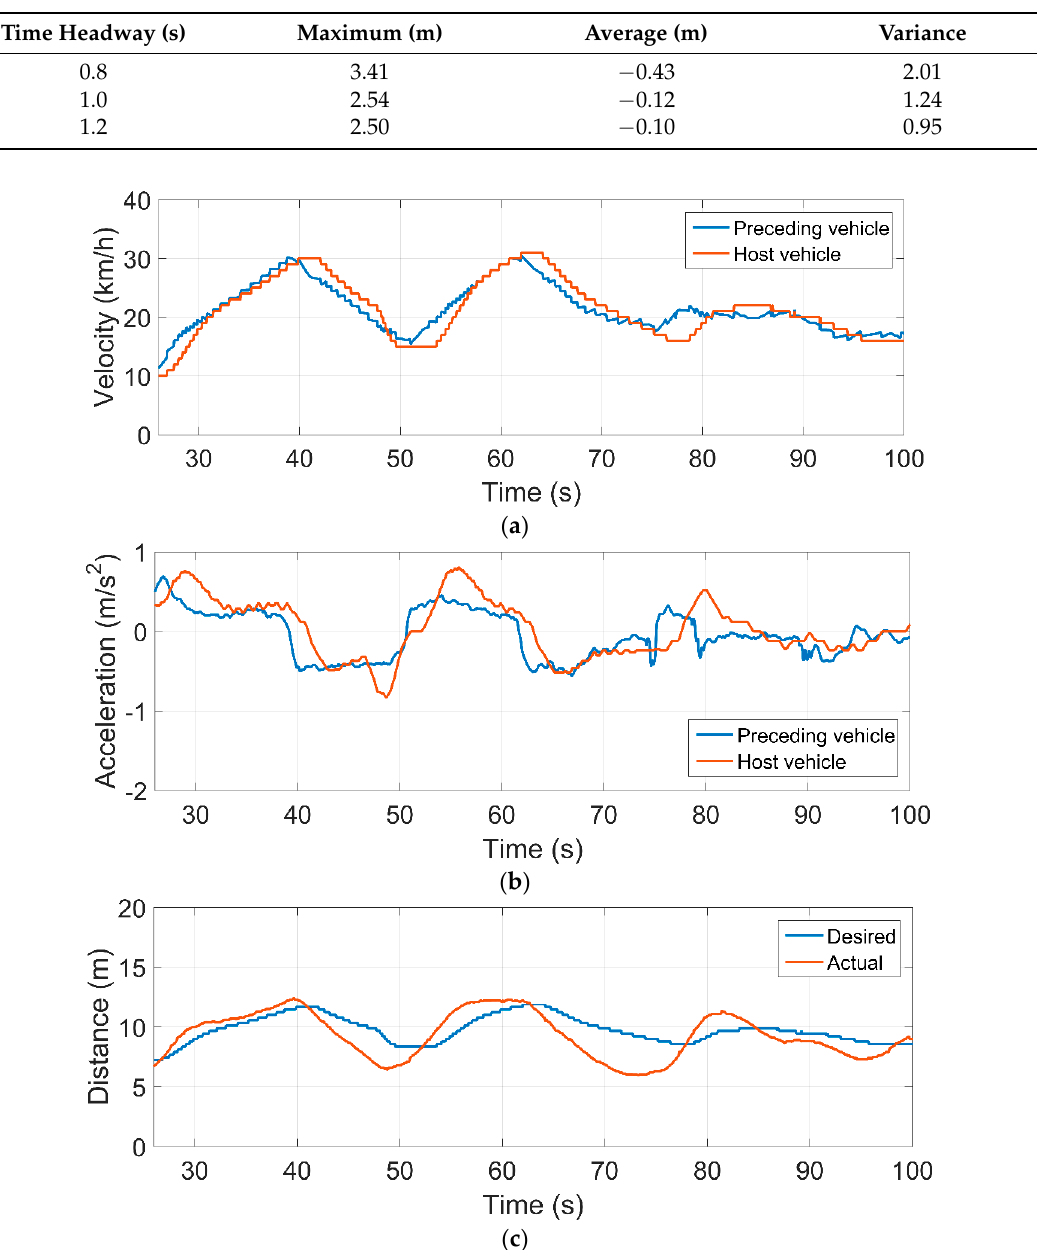
Table 5. Maximum, average, and variance of distance error, with the real driving cycle.